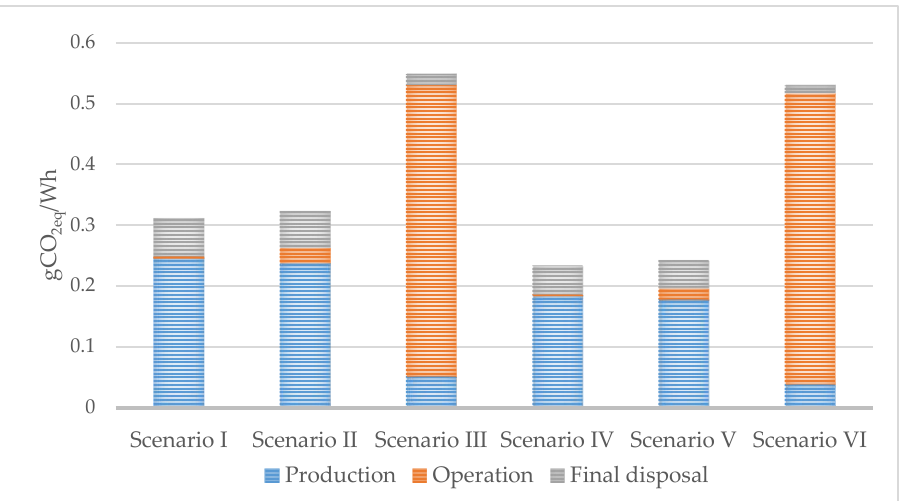
Figure 8. GWP results for TE cooling system with heat recovery including life cycle stages, gCO 2eq / Wh. Table 9. GWP results reduction by prolongation of expected lifetime to 20 years, %.